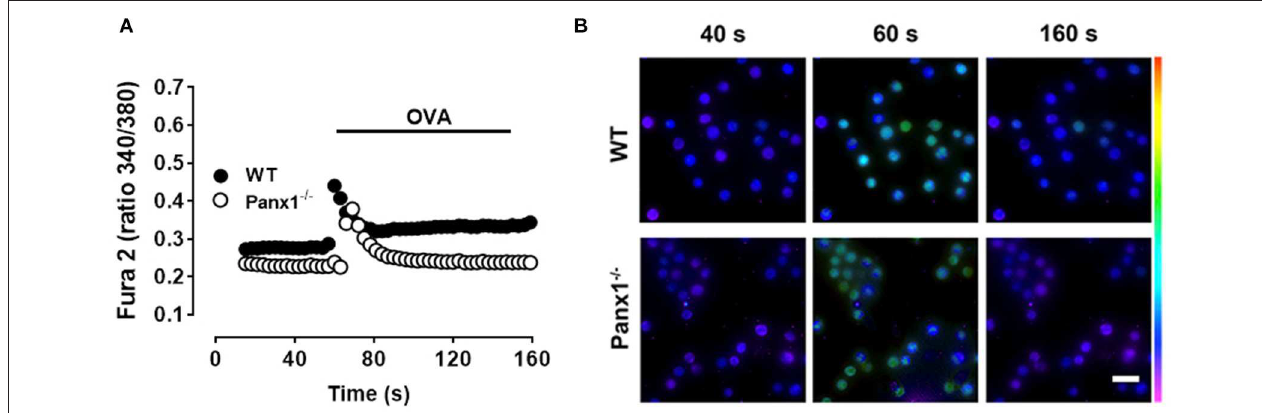
FIGURE 2 | The OVA-induced Ca 2 + signal of Panx1 − / − mast cells is partially impaired. (A) Representative intracellular Ca 2 + signal in WT (black) and Panx1 − / − (white) mast cells (MCs). In Fura-2-loaded sensitized MCs, the Ca 2 + signal was first recorded under basal conditions during 50s and then were exposed to 10 µ M OVA (black trace). Each value corresponds to the mean ± SEM of Ca 2 + signal recorded in 50 cells. A total of five independent experiments were performed. (B) Fields of representative Fura-2 fluorescence before (40s), during (60s), and after (160s) OVA exposure of WT and Panx1 − / − MCs treated as in (A) . Scale bar, 20 µ m.